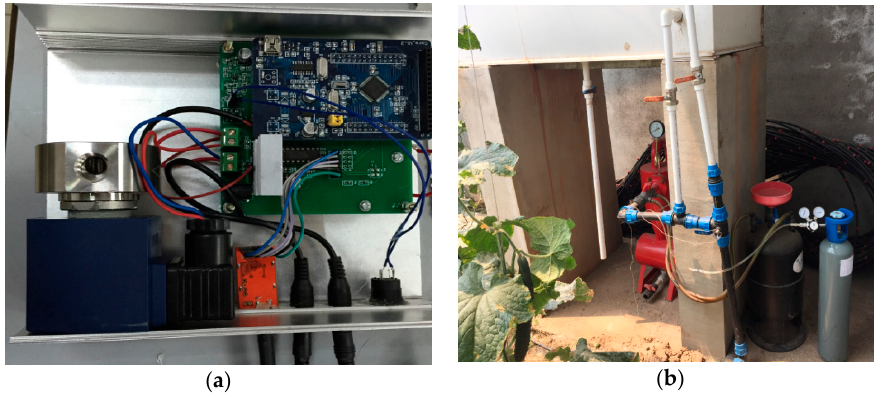
Figure 11. ( a ) The photo of the control facility; ( b ) The practical installment of control facilities in the greenhouse.